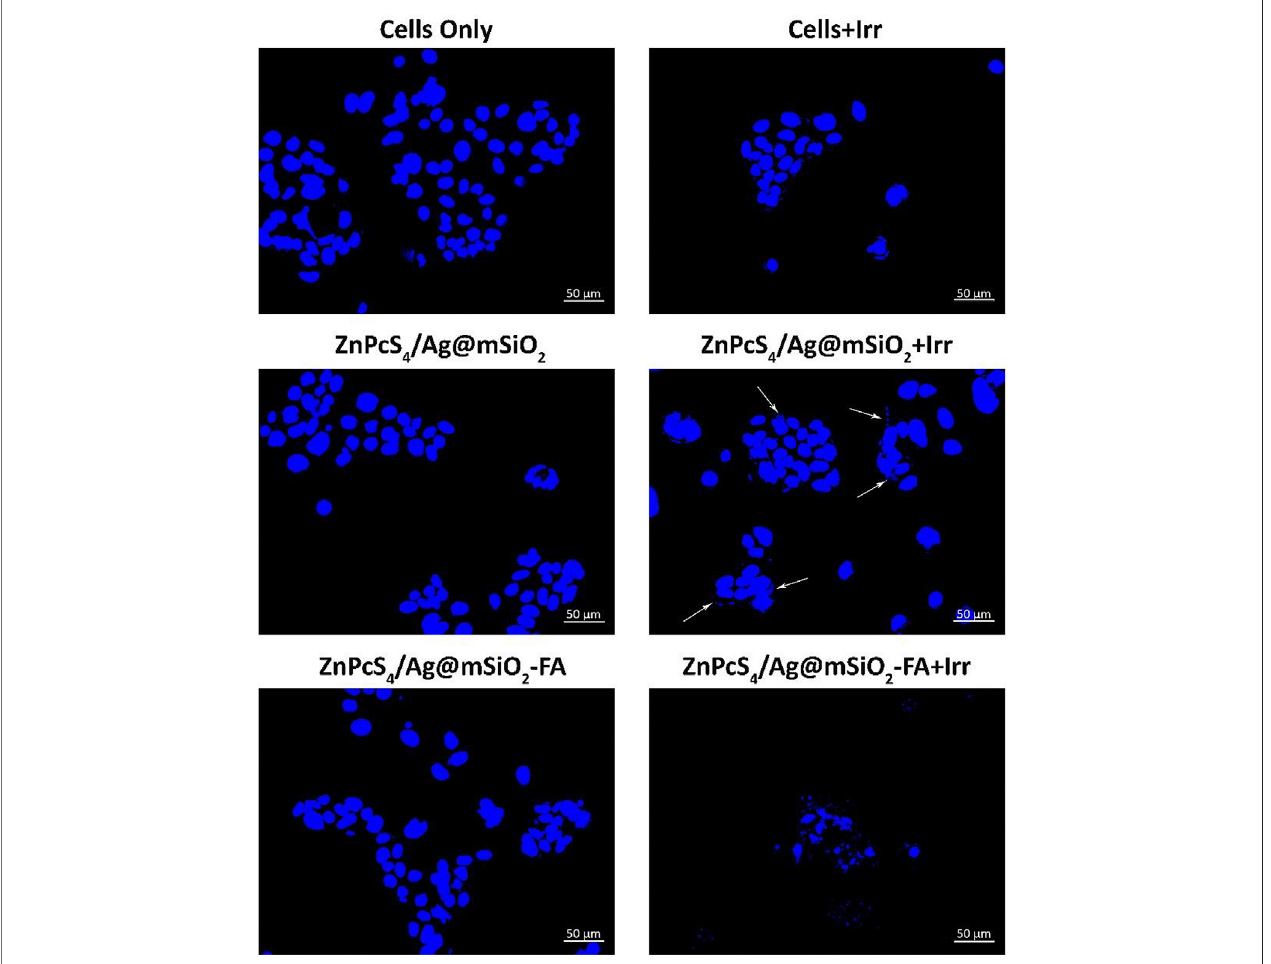
FIGURE 5 | Hoechst 33258 Caco-2 cells nuclear DNA damage with the passive and fi nal actively targeted NCs.